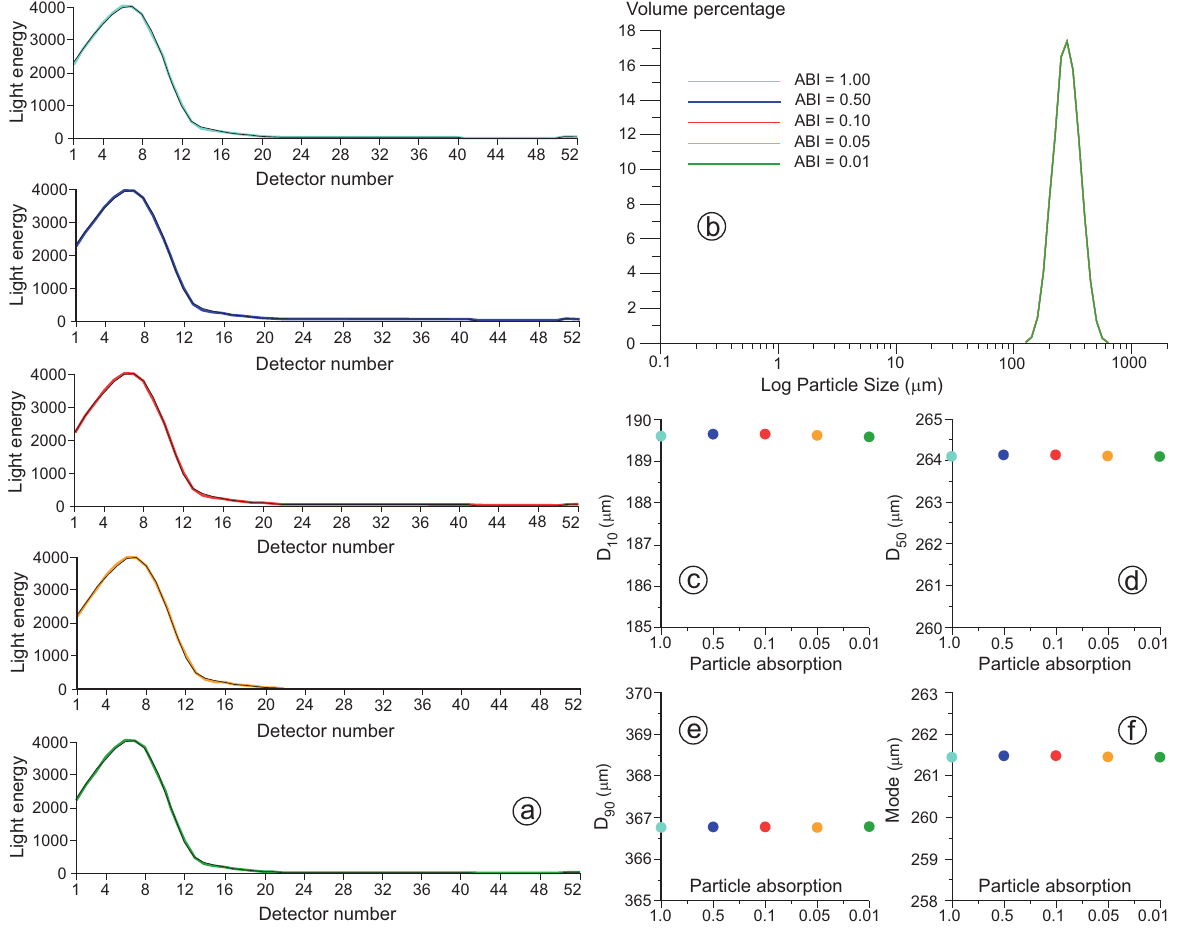
Fig. 21. Reprocessing of the first run data from test MP2500 5 on sub-sample aliquot SAND1c (Fig. 8). (a) Light scattering data (black curve) and corresponding best fits for constant RI values of quartz=1.5, variable ABS values of quartz from 0.01 to 1.00 (colour code in (b)), and constant RI values of decalcified tap water=1.33. (b) Granulometric curves computed from reprocessed data in (a). (c) D 10 percentiles for data in the 5 curves illustrated in (b). (d) D 50 percentiles for data in the 5 curves illustrated in (b). (e) D 90 percentiles for data in the 5 curves illustrated in (b). (f) Modal values for data in the 5 curves illustrated in (b). It is worth noting that changing also ABS of quartz produces negligible changes in the reprocessed